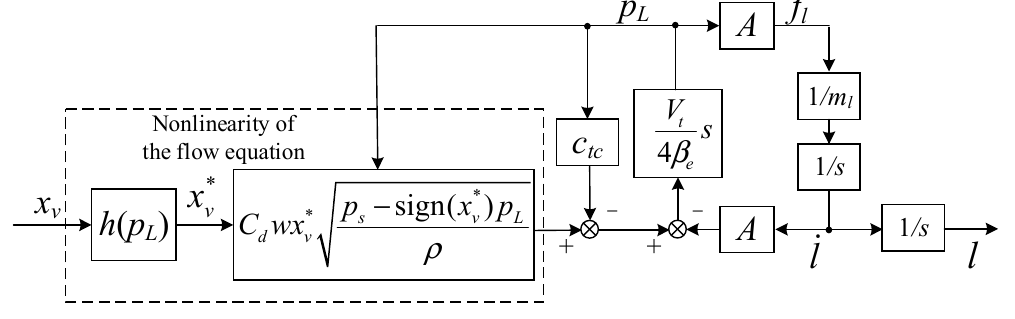
Figure 7. Flow nonlinear compensation control.